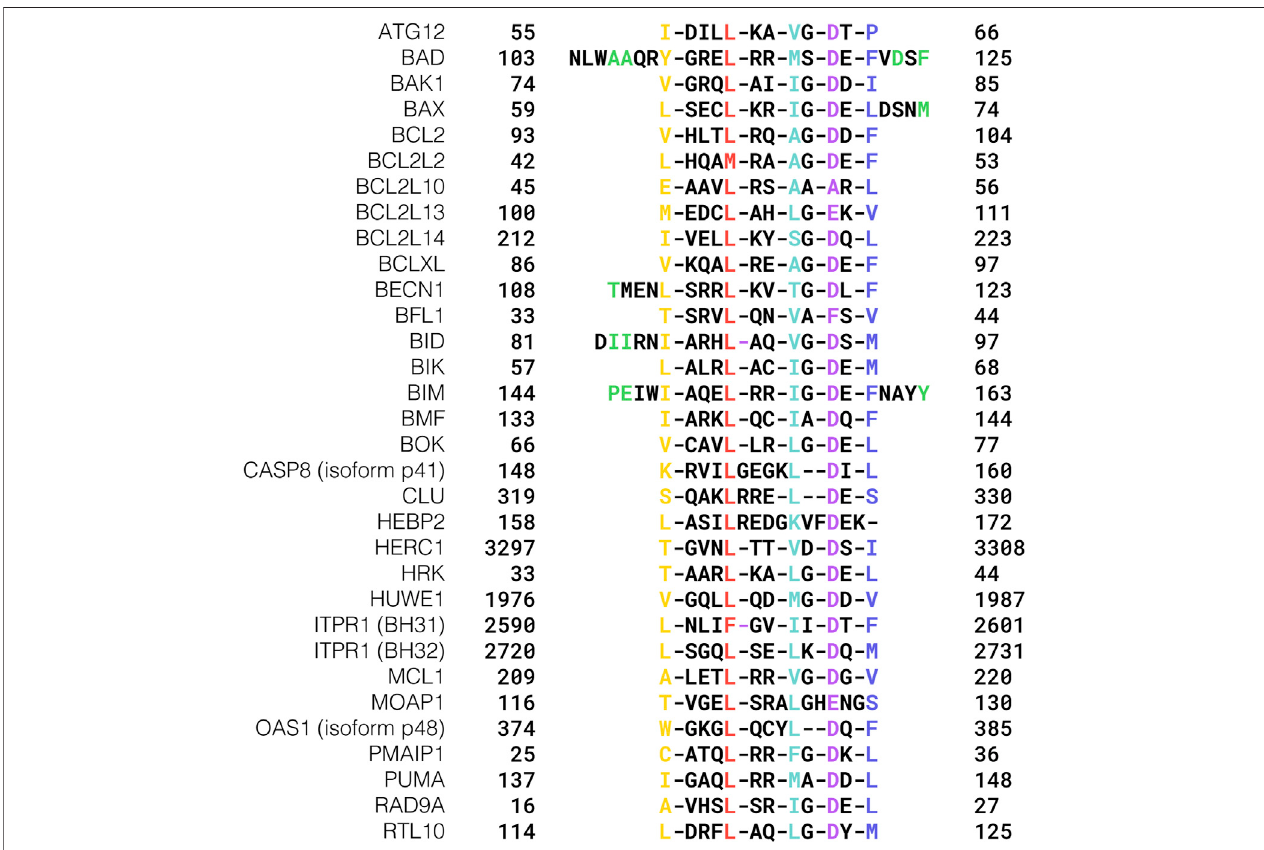
FIGURE 1 | Core sequences of experimentally validated BH3 motifs. Conserved hydrophobic positions are highlighted in yellow, red, mint green, and blue, respectively, while the acidic hotspot is colored purple. BH3s whose fl anking regions are examined in the text are reported in their extended version, and the residues discussed are colored